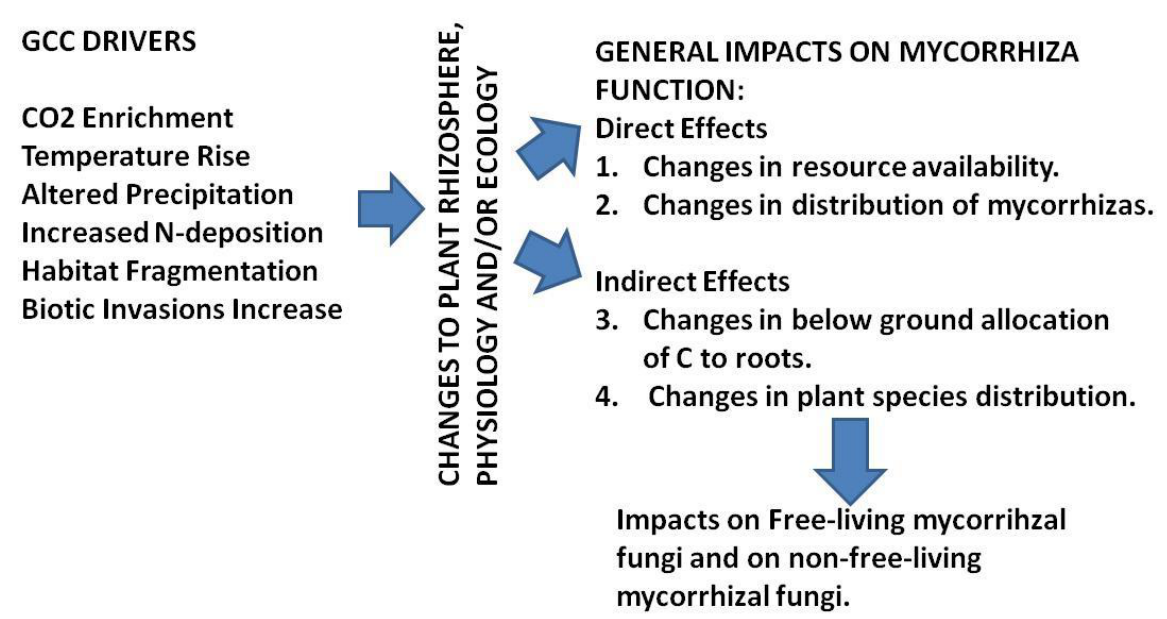
Figure 3. Environmental drivers conceptually impart changes to plants which ultimately influence mycorrhizal associations and mycorrhizal fungi. The drivers are well documented as well as the changes to plants (see Table 5). The impacts on mycorrhiza are putative, and impacts on mycorrhizal fungi somewhat speculative. Putative impacts are conjectured in Table 5, but they do have a basis in the literature (see